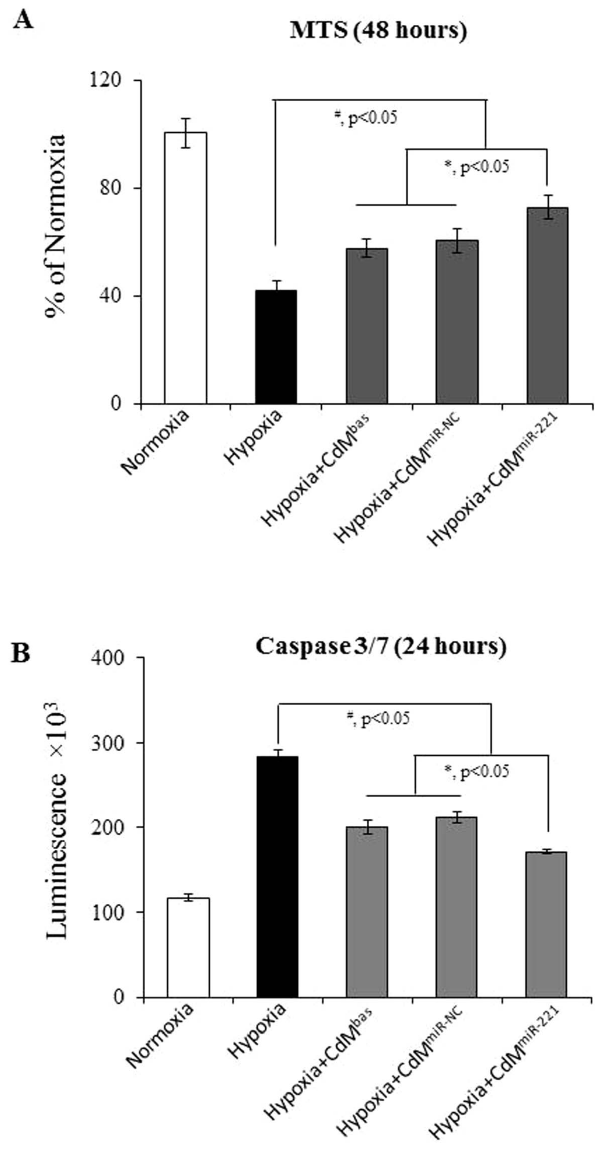
Figure 4. miR-221 expression enhances MSC-mediated cardi- oprotection against hypoxic injury. Panel A: MTS uptake by CM exposed to 48 hours hypoxia. Panel B: Caspase 3/7 activity in CM after 24 hours hypoxia. CdM bas : CdM derived from MSC bas ; CdM miR-NC : CdM derived from MSC miR-NC ; and CdM miR-221 : CdM derived from MSC miR-221 .